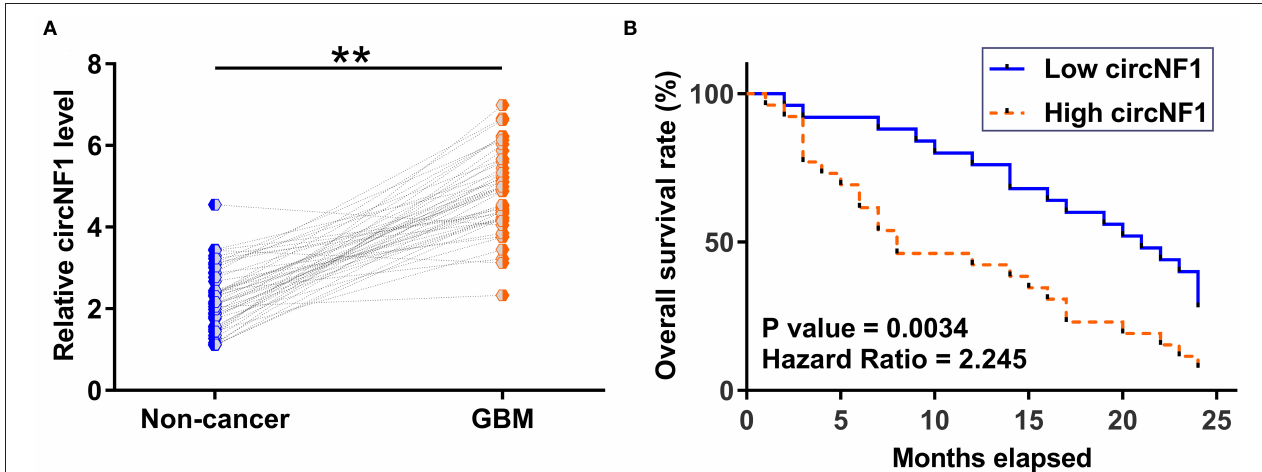
FIGURE 1 | Glioblastoma (GBM) exhibited an overexpression of circNF1, and high levels of circNF1 predicted poor survival. (A) Paired GBM and non-cancer tissues from GBM patients ( n = 50) were subjected to RNA isolation and RT-PCR to analyze the expression of circNF1. Levels of circNF1, mature miR-340, and miR-340 precursor in paired tissues were expressed as average values of three technical PCR replicates, and data comparisons were performed by paired t -test. ** p < 0.01. The 50 GBM patients were divided into high- and low-circNF1-level groups ( n = 25; with a median level of circNF1 expression in GBM as a cutoff value). Based on the 2-year follow-up data, survival curves were plotted, and comparisons were performed using the log-rank test (B)